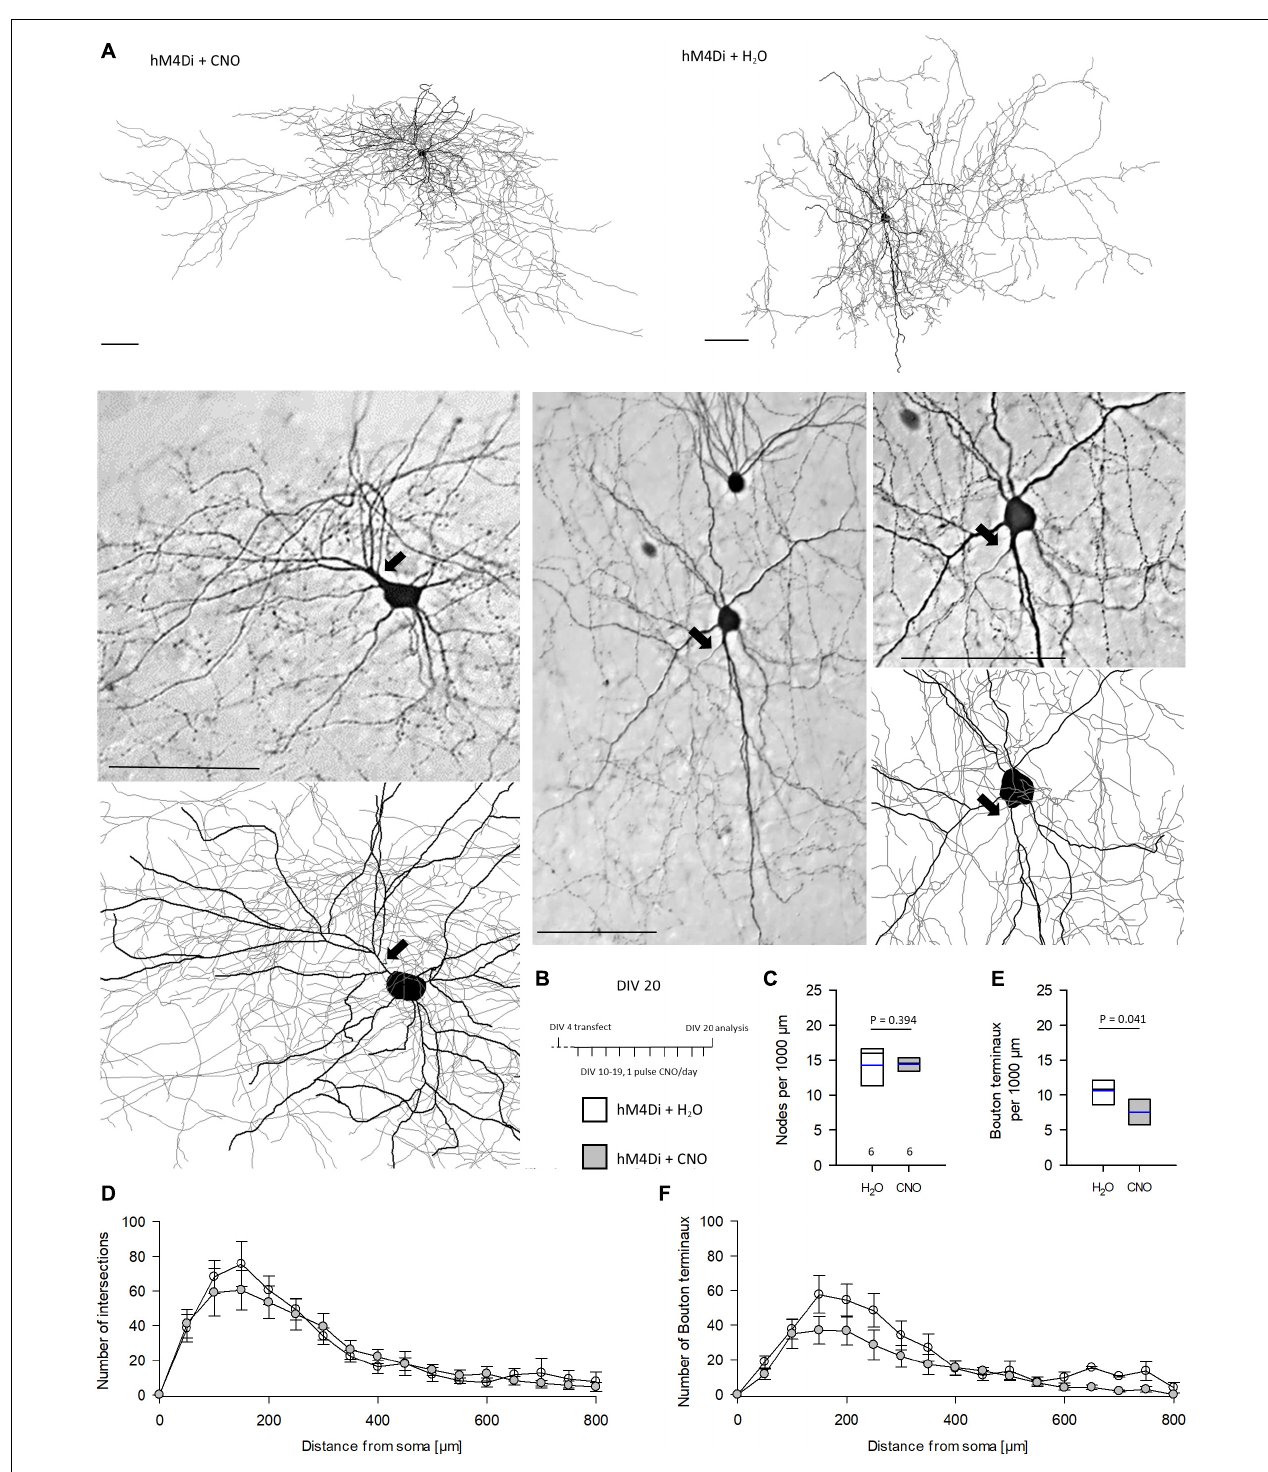
FIGURE 5 | Prolonged reduction of activity via hM4Di reduces the number of bouton terminaux of basket cells axons. (A) Two representative cells, one each of CNO and H 2 O treatment, are shown as a reconstruction overview (thick lines, dendrites; thin lines, axons), and as photomicrograph and detail of the reconstruction. Axons are marked by arrows. (B) Stimulation protocol. (C) Number of nodes per 1,000 µ m. (D) Sholl analysis and total intersections of reconstructed basket cells. (E) Number of bouton terminaux per 1,000 µ m. (F) Sholl analysis of bouton terminaux; note that the density remained below that of control cells over the entire distance. Numbers of analyzed neurons are given below the box plots in panel (C) . Black lines in the box plots represent the median and blue lines indicate the mean. Mann–Whitney rank sum test H 2 O vs. CNO, P -values are reported. Scale bars: 100 µ m.